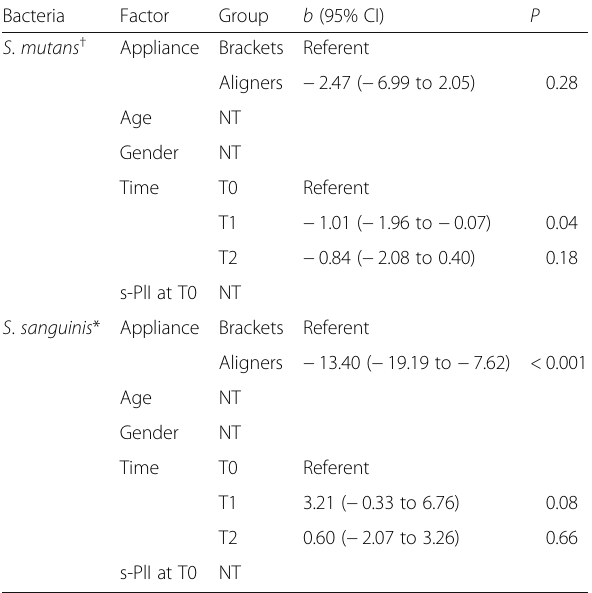
Table 6 Linear regressions with S . sanguinis or S . mutans counts (transformed) as dependent variable. The initial crude model coincided with the adjusted model, as no covariates were